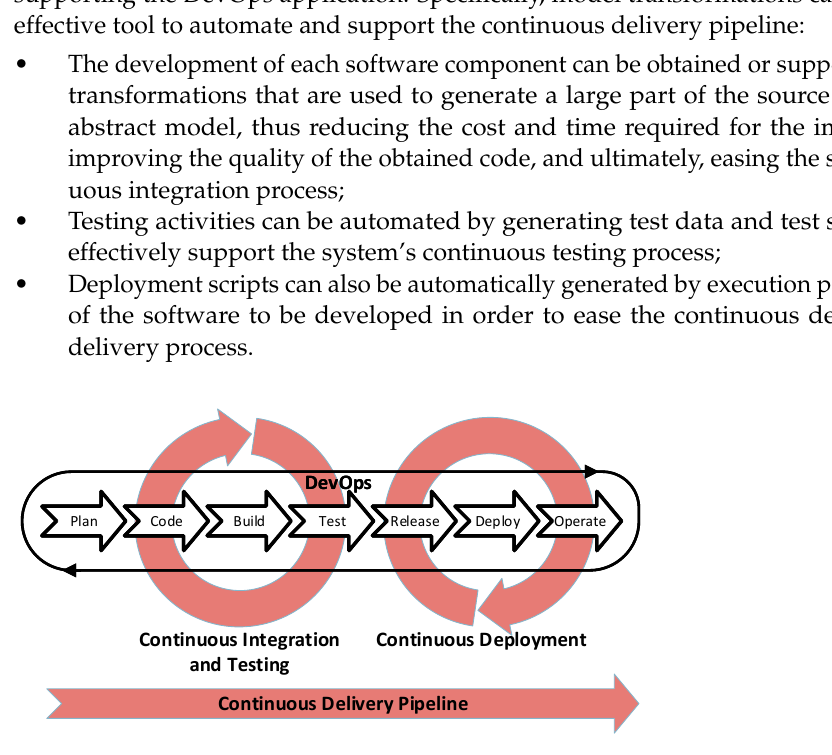
Figure 3. DevOps with Continuous Integration, Continuous Deployment and